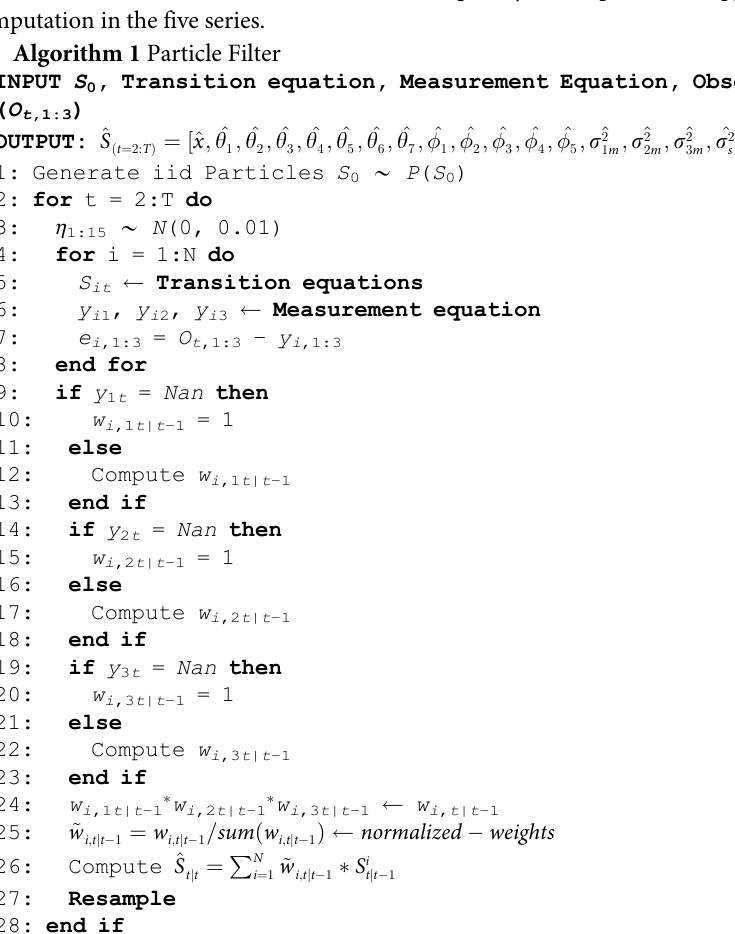
Algorithm 1 Particle Filter